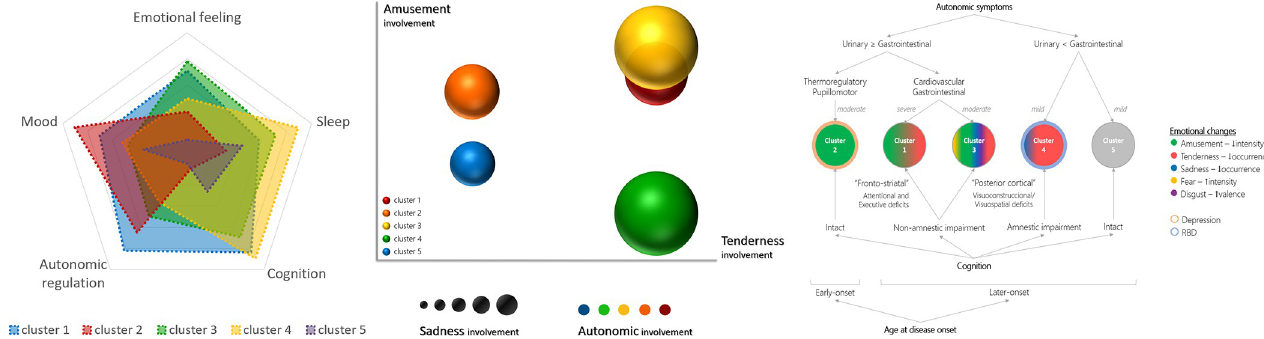
Fig 2. Dominant non-motor characteristics in the clusters of patients with Parkinson’s disease. (A) Relative involvement of the non-motor domains (higher score represents greater impairment). The domain of emotion summarizes the deficits in Amusement intensity, Tenderness occurrence, and Sadness occurrence. (B) Delineation of PD cluster across the feature space representing the involvement of Amusement intensity vs . Tenderness occurrence; the involvement of Sadness occurrence and autonomic manifestations is represented by the relative size and color of bubbles, respectively. The graphs show the standardized mean or median scores (n = 28 patients). The inverse value was presented in the case of those features for which a greater score denotes a better status. c1-c5: Cluster 1—cluster 5. (C) Deficits in subjective emotional experience across autonomic and cognitive profiles. Autonomic symptoms with a substantial relative contribution and cognitive domains with more prominent impairments are illustrated. RBD: Rapid eye movement sleep behavior disorder.